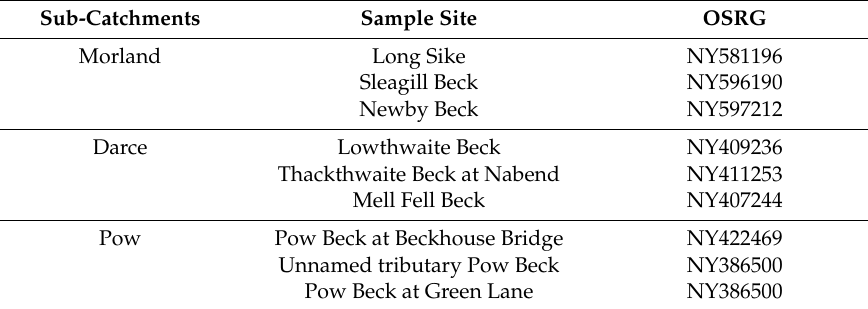
Table 4. Biweekly sampling of Field Beck Water from the Eden Catchment